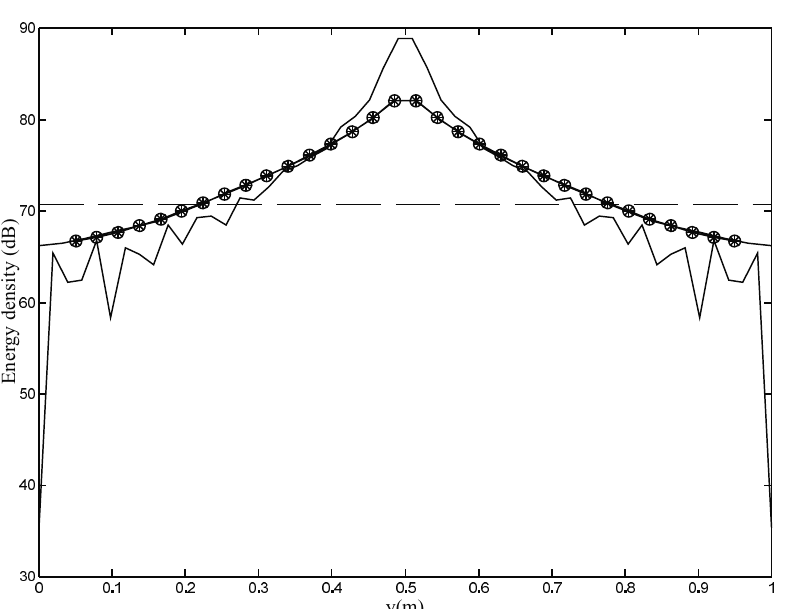
Fig. 6. Comparison of the energy density distributions in rectangular plate predicted by classical solution (—); SEA solution (- - -); EFA analytic solution ( ); direct EFBEM solution ( ) and indirect EFBEM solution ( ) along the representative line when f = 1 kHz and η = 0 . 2 . The reference energy density is 1 × 10 − 12 J/m 2 .